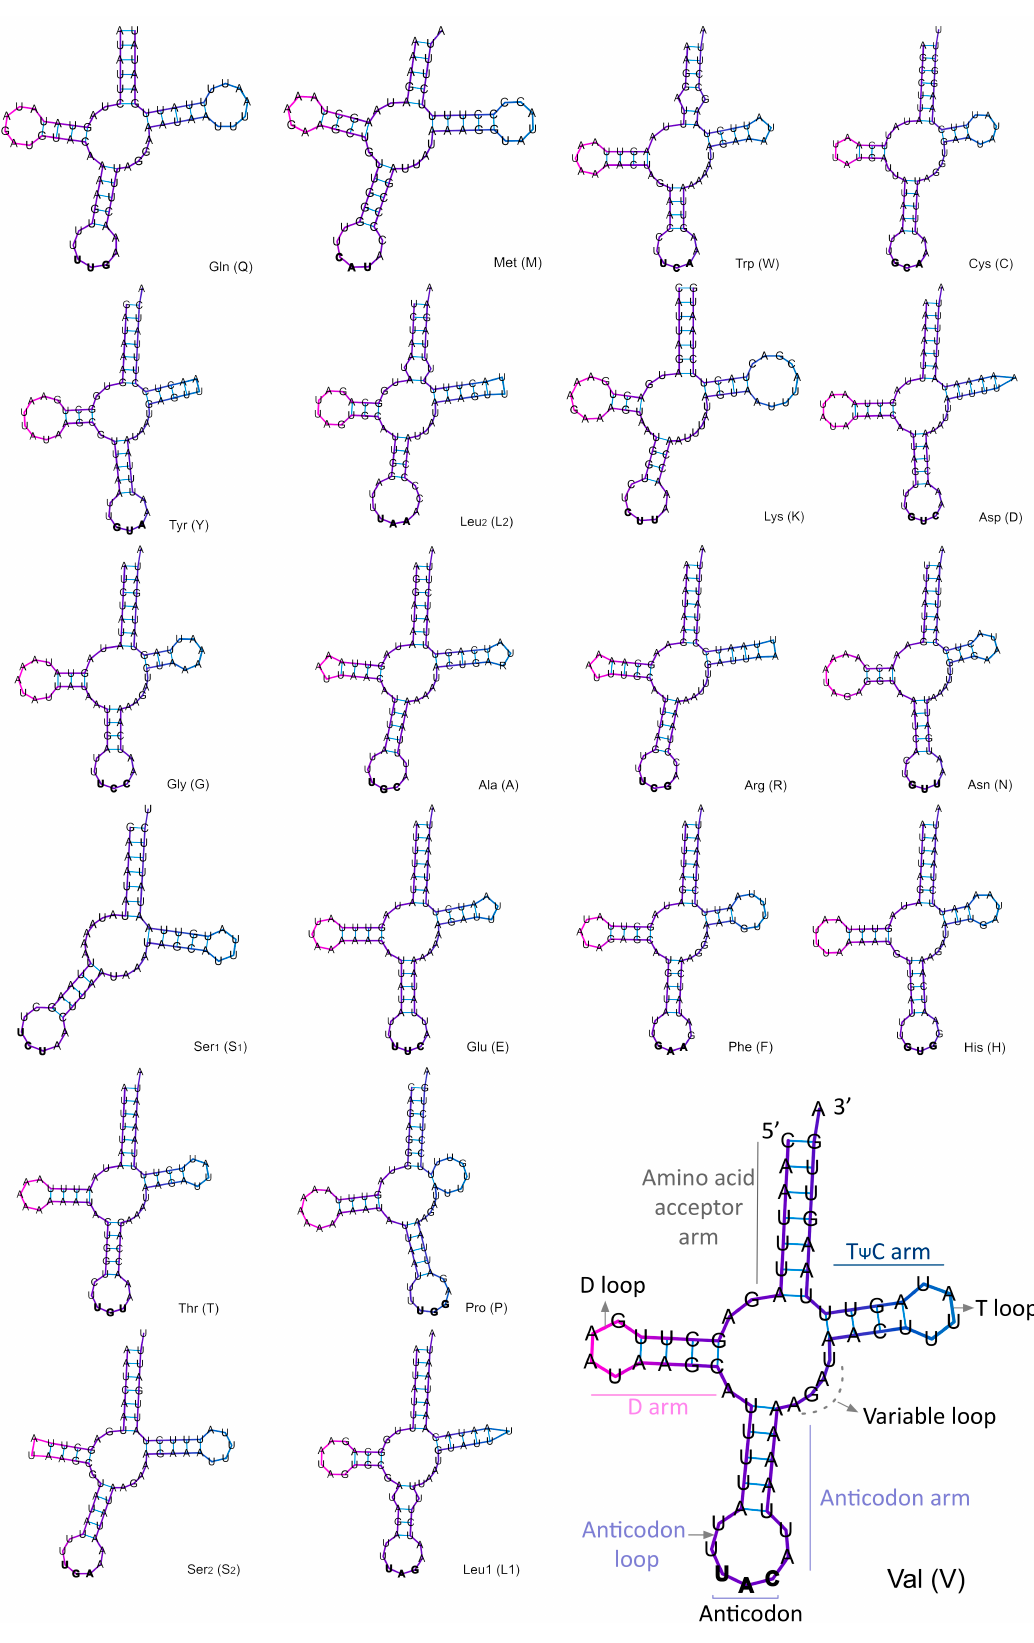
Figure 8. Predicted secondary structure of 21 transfer RNAs (tRNAs) of Eriopis patagonia mitogenome. Bars indicate Watson–Crick base pairings.